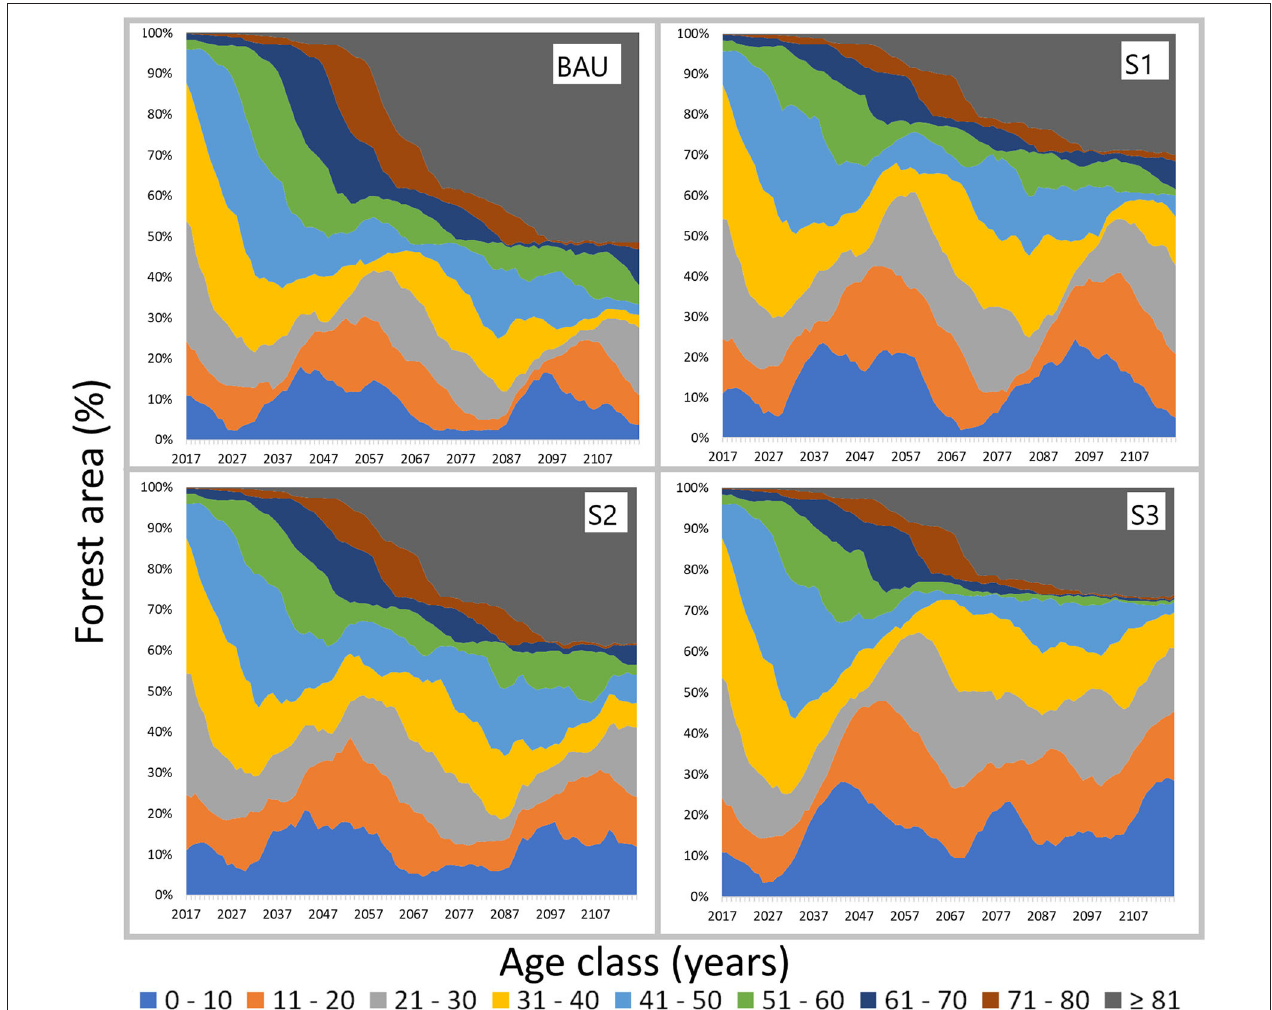
FIGURE 3 | Percent forest area by age class over the planning horizon for four